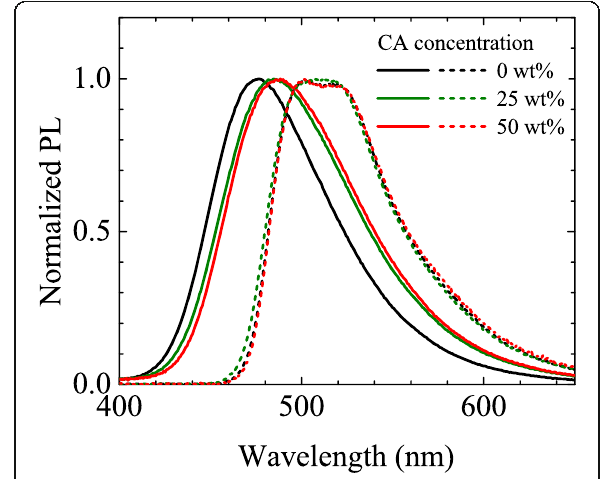
Fig. 3 Fluorescence ( solid lines ) and phosphorescence ( dashed lines ) spectra of 2CzPN-doped m-CP:CA thin films. Black , green , and red lines represent the data for CA concentrations of 0, 25, and 50